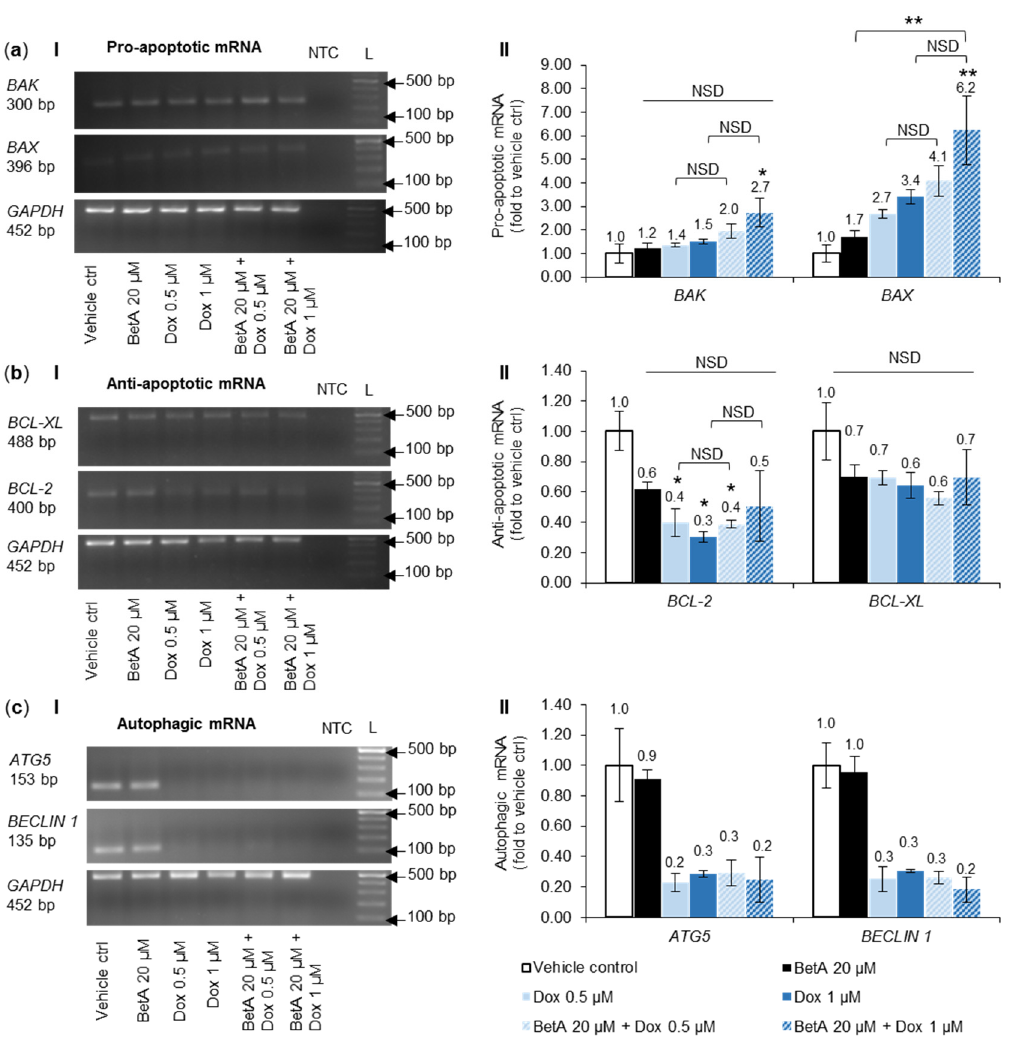
Figure 6. Expression of apoptotic Bcl-2 family members and autophagy genes in MOLM-13 cell lines co-treatment with single and combination drugs after 48 h. RT-PCR gene expression detection by gel electrophoresis ( I ) of MOLM-13 treated cells were quantified ( II ) using ImageJ software. The mRNA expression of pro-apoptotic ( a ) BAK and BAX ( n = 3), anti- apoptotic ( b ) BCL-2 and BCL-XL ( n = 3), and autophagy ( c ) ATG5 and BECLIN 1 ( n = 2) is relative to vehicle control (DMSO 0.05%, represented as 1.00-fold) and ratio between normalised data and GAPDH (housekeeping gene). NTC—non-template control. L—molecular ladder PCRBIO Ladder IV (100–1500 bp). Results were expressed as mean + SE. The data set was analysed by one-way ANOVA; Tukey post-hoc test. Statistical difference was accepted as following: p > 0.05 no sig-